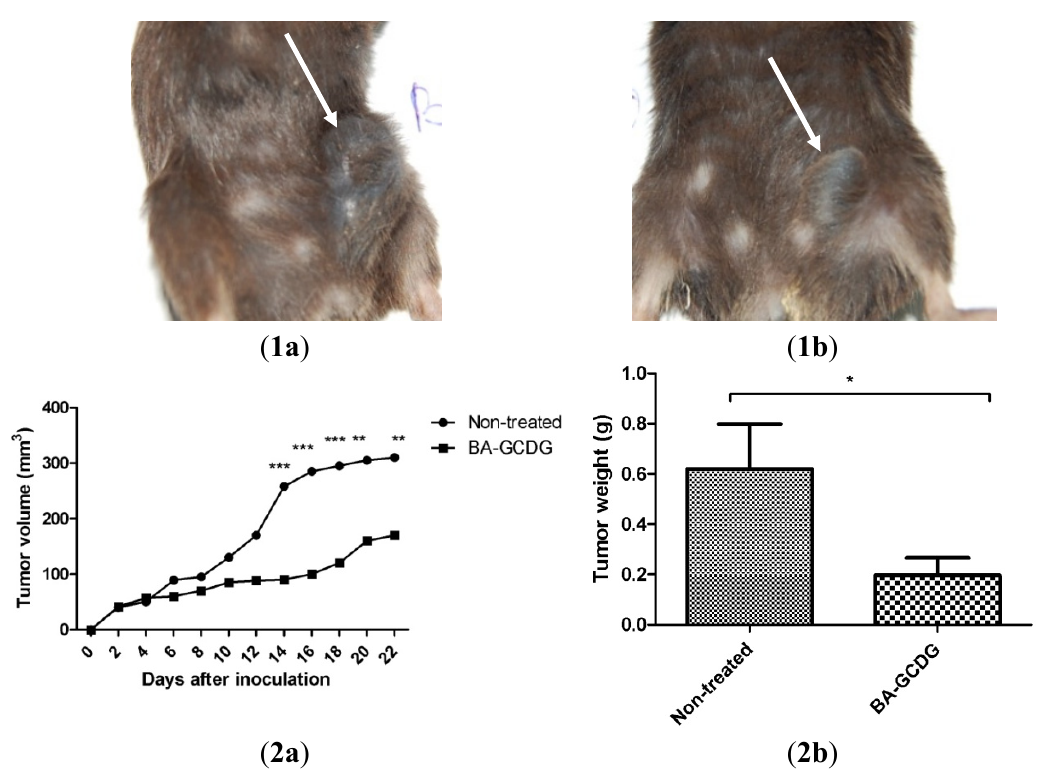
Figure 8. ( 1 ) Macroscopic images of tumor development on day 21 of the experiment developed in C57BL/6J mice: ( a ) Non-treated group (control group); and ( b ) BA:GCDG complex-treated group. ( 2 ) Tumor development: ( a ) Tumor volume (mm 3 ); and ( b ) Tumor weight (g) for the treated and non-treated groups. Tumor growth (mm) was measured daily using a caliper, and tumor volume was estimated by using the following formula: length × width 2 /2. The administration of BA complex started on the first day after the murine melanoma cells were inoculated and was performed daily (100 mg/kg, intraperitoneally) until the final day of the experiment. Paired Student’s t tests or one-way ANOVA followed by Bonferroni’s post-tests were used; p < 0.05 ( * ), p < 0.01( ** ) and p < 0.001 ( *** ) are indicated.